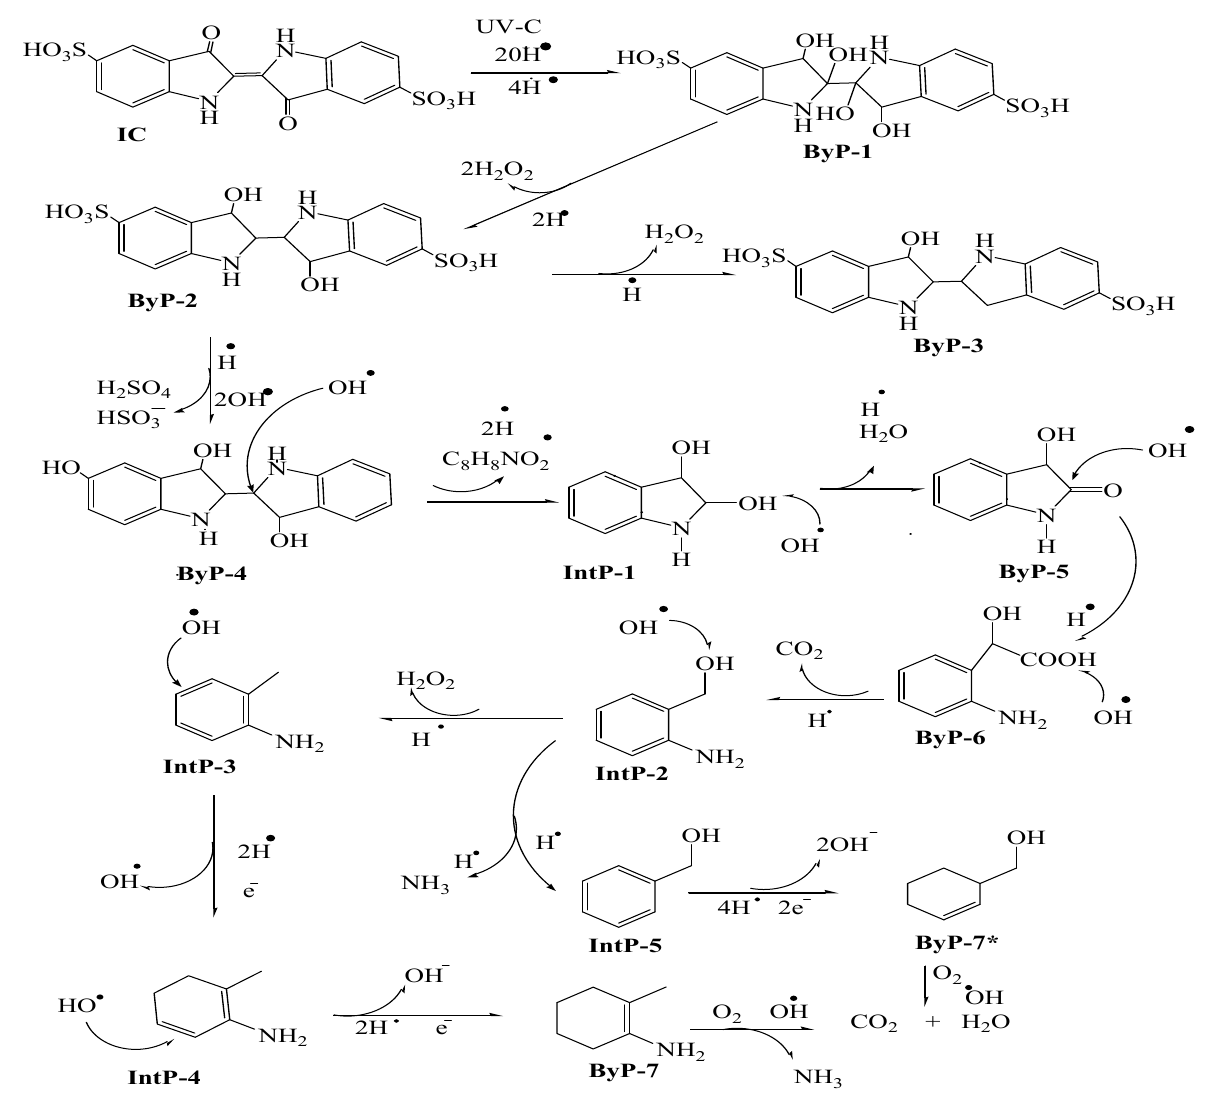
Figure 11. Mechanism of indigo carmine degradation via the Fenton process .